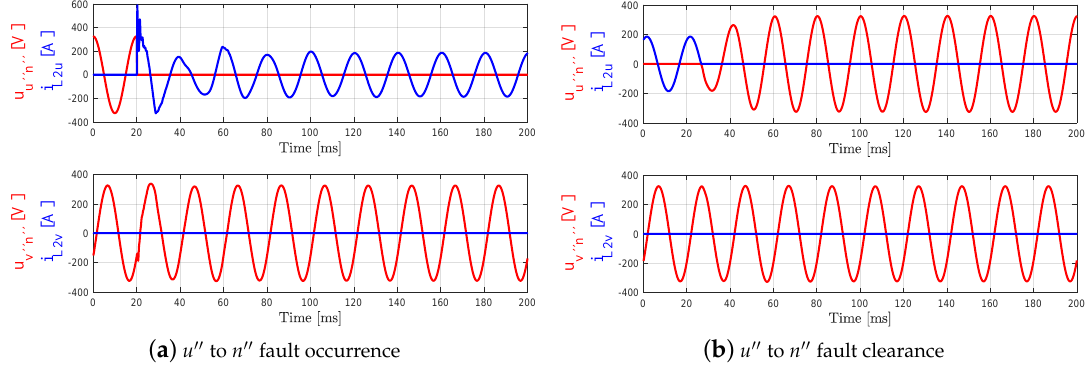
Figure 12. Scenario 1 (simulated phase to neutral short-circuit fault).